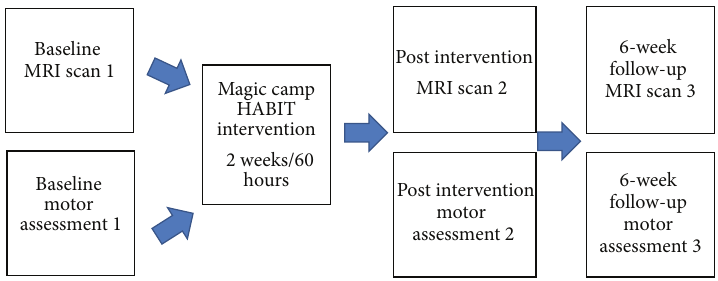
Figure 1: General study set-up for Magic camp HABIT